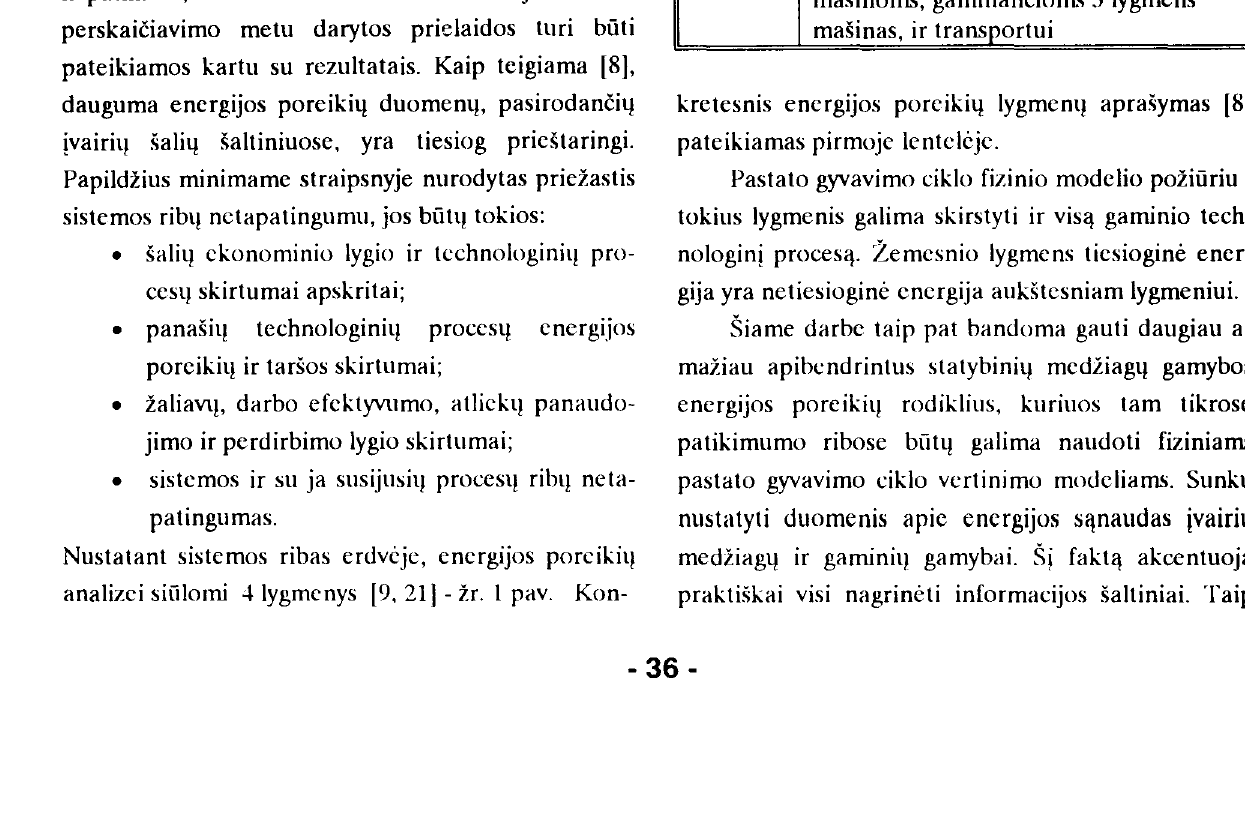
1 lentek. Energijos porcikil) lygmcn4 aprasymas Table 1. Description of energy requirement